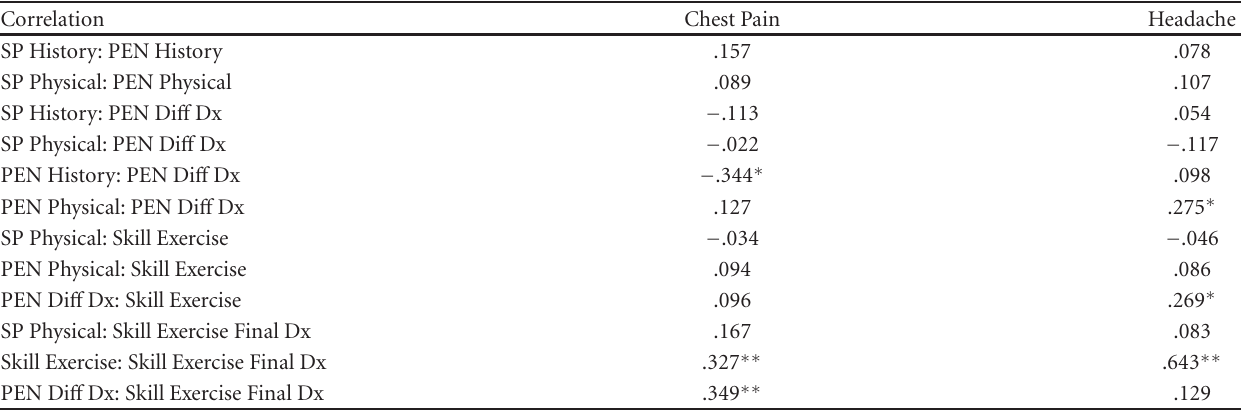
Table 1: Spearman rank order correlations coe ffi cients for associations between standardized patient (sp) history and physical exam Scores, Student Post-Encounter Note (PEN) History, Physical Exam and Di ff erential Diagnosis Scores (Di ff Dx), Postencounter Skill Exercise Scores, and Skill Exerecise Final Diagnosis (Final Dx)